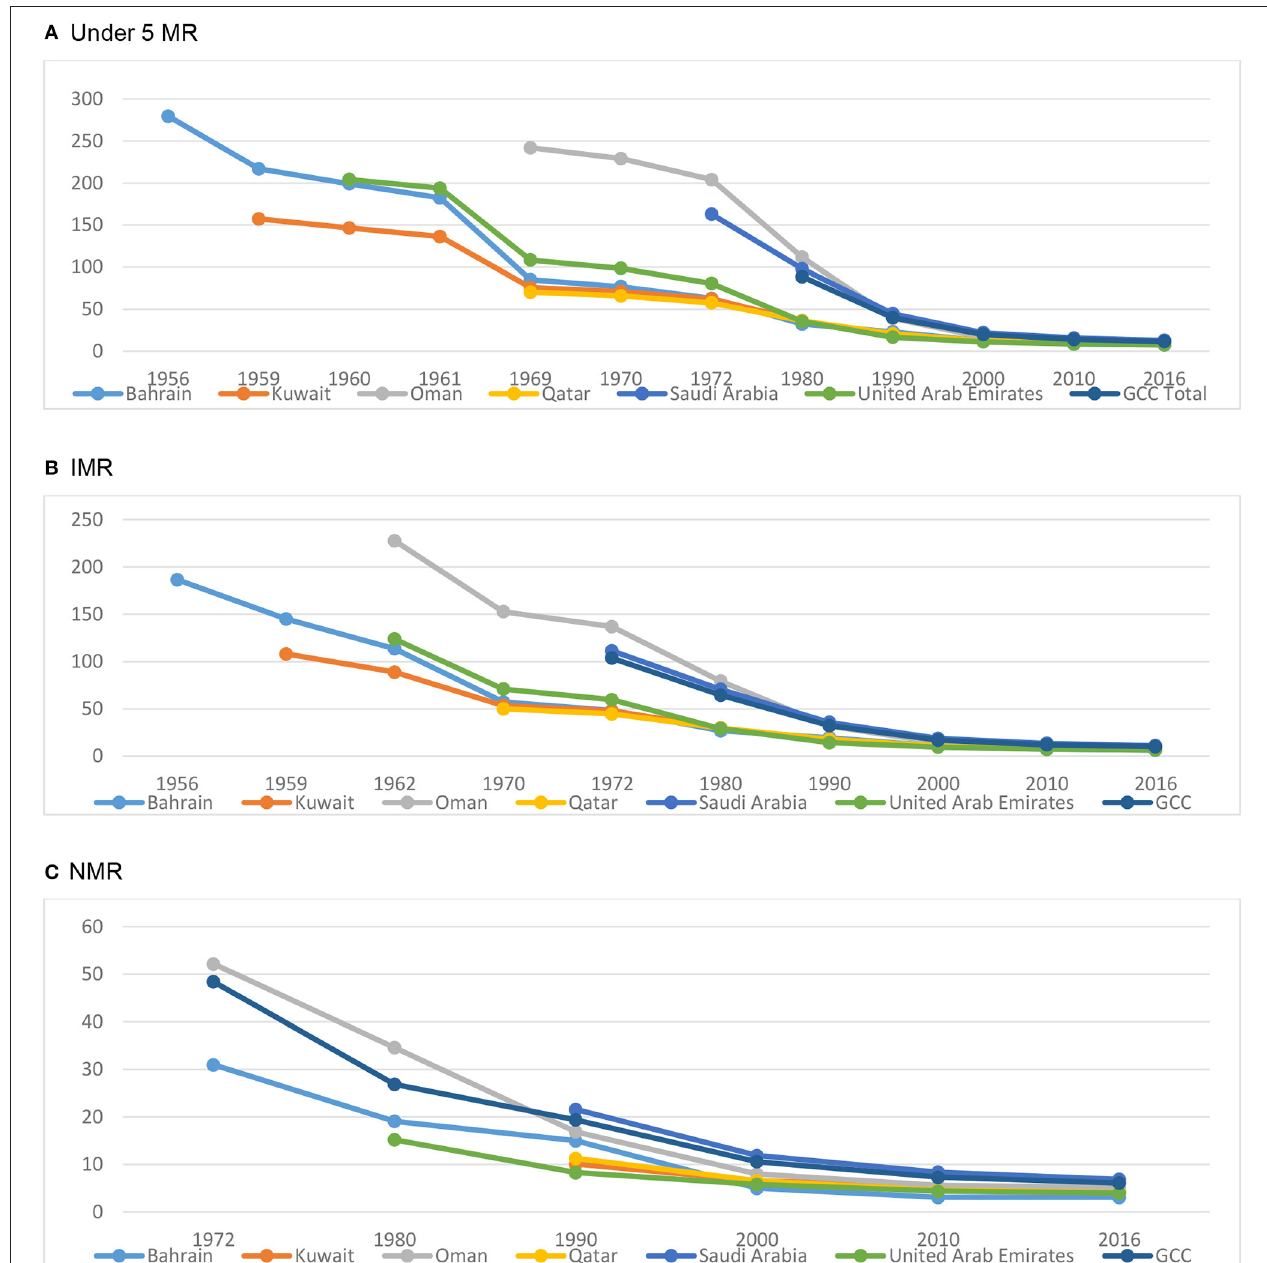
FIGURE 1 | Child mortality in the Arabian Gulf since 1956. (A) Under 5 MR, (B) IMR, (C) NMR. Source of data: UN Inter-agency Group for child Mortality Estimation (UN IGME), as 2017 release (www.childmortality.org). Data used in plotting this graph is shown in Appendix 2